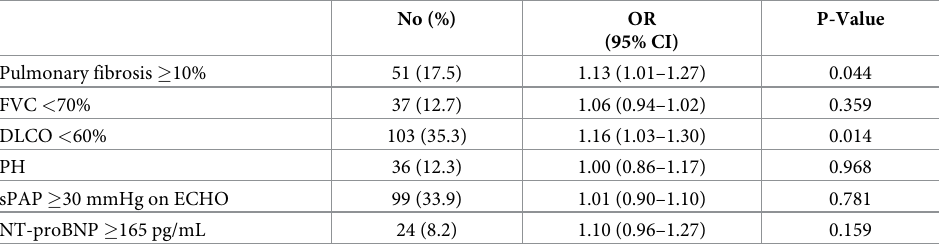
Table 2. CX 3 CL1 concentrations are associated with baseline cardiopulmonary characteristics by multivariable logistic regression analyses.